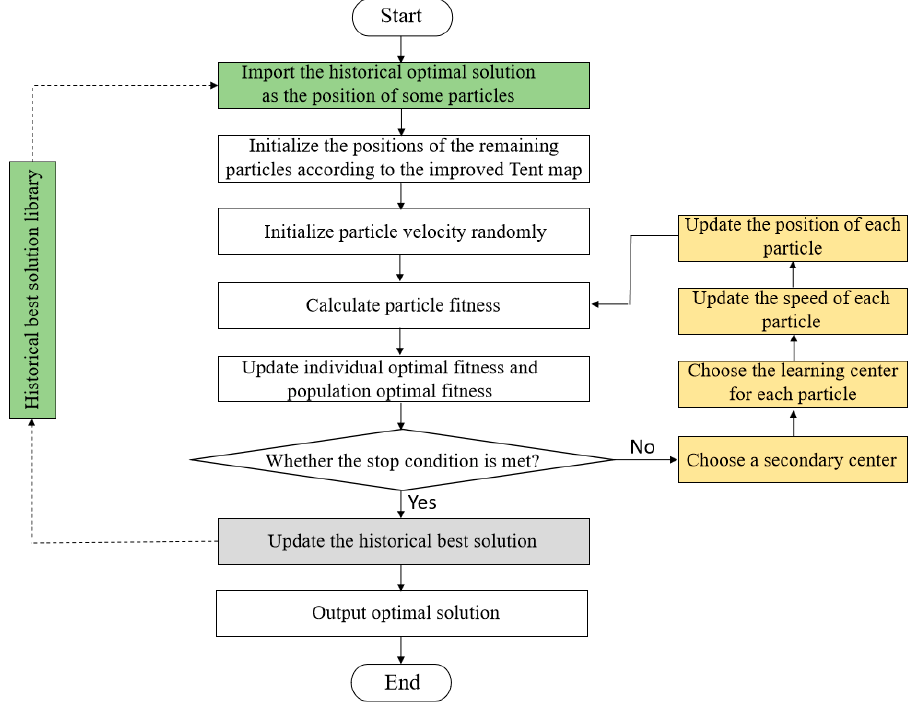
Figure 3. The schematic flowchart of the modified PSO algorithm.